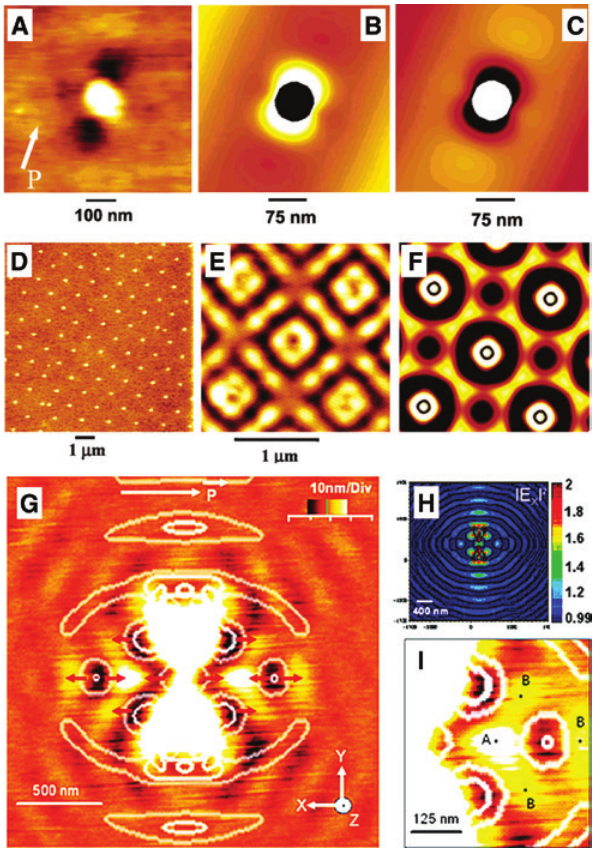
Figure 9: Photochemical imaging of optical fields in the form of surface reliefs.